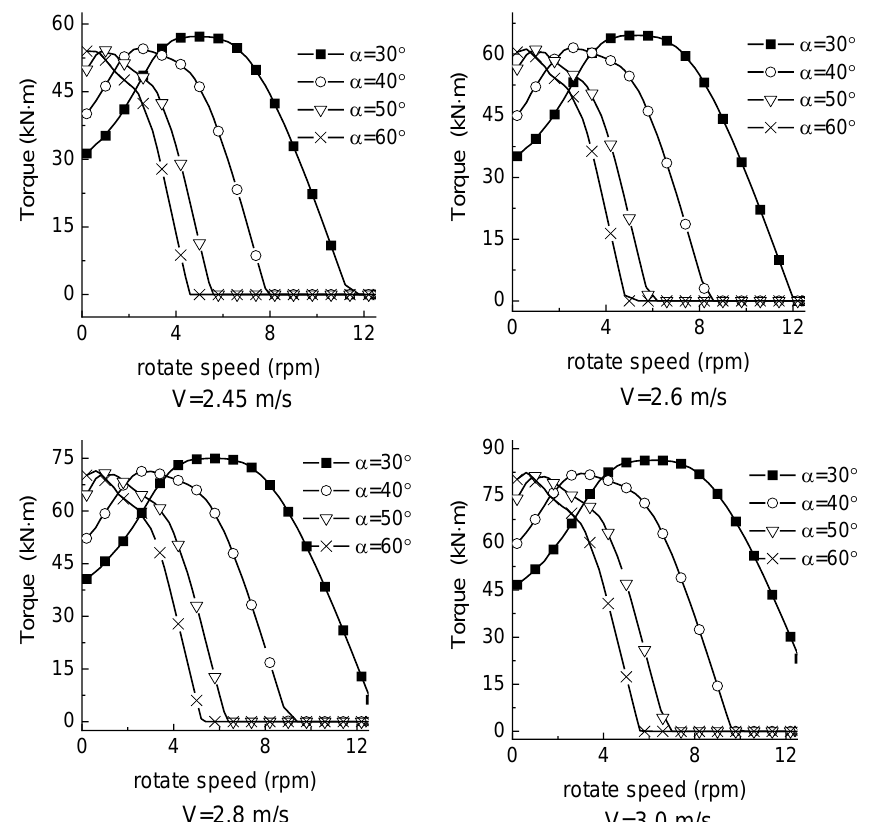
Figure 12. Dynamic characteristics of an impeller with a high pitch angle under high flow